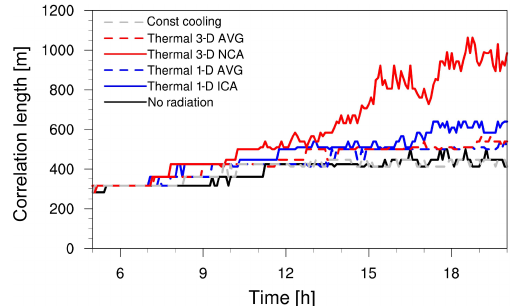
Figure 22. Temporal development of the correlation length for the 100m resolution simulation. The correlation length is defined by the shift where the correlation coefficient drops below 1 /e